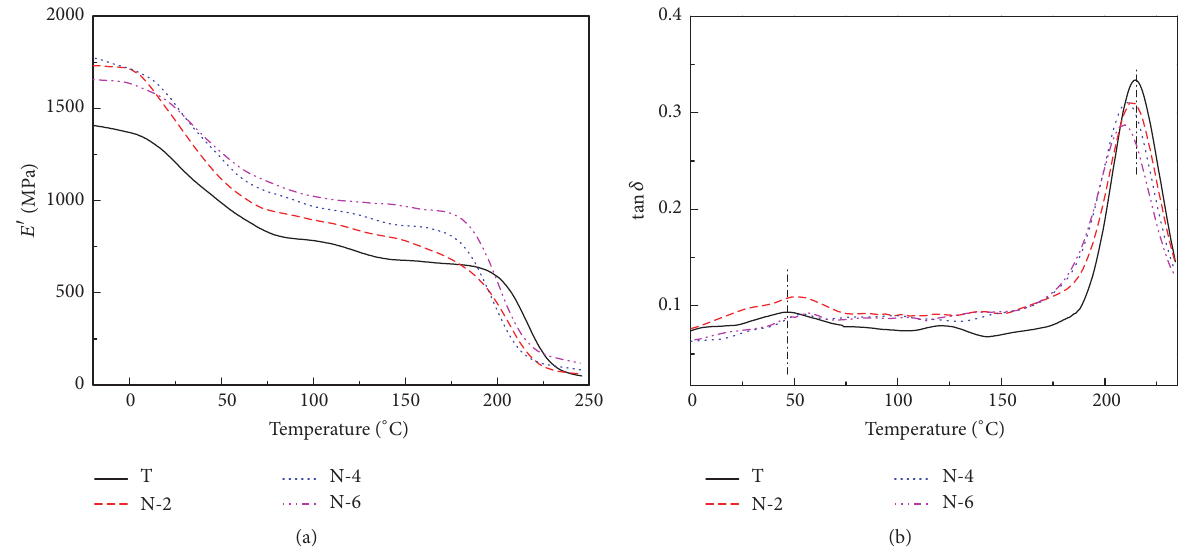
Figure 8: (a) Storage modulus ( 𝐸 󸀠 ) and (b) loss factor (tan 𝛿 ) patterns of DMTA for PPO/PA66 blends and nanocomposites.